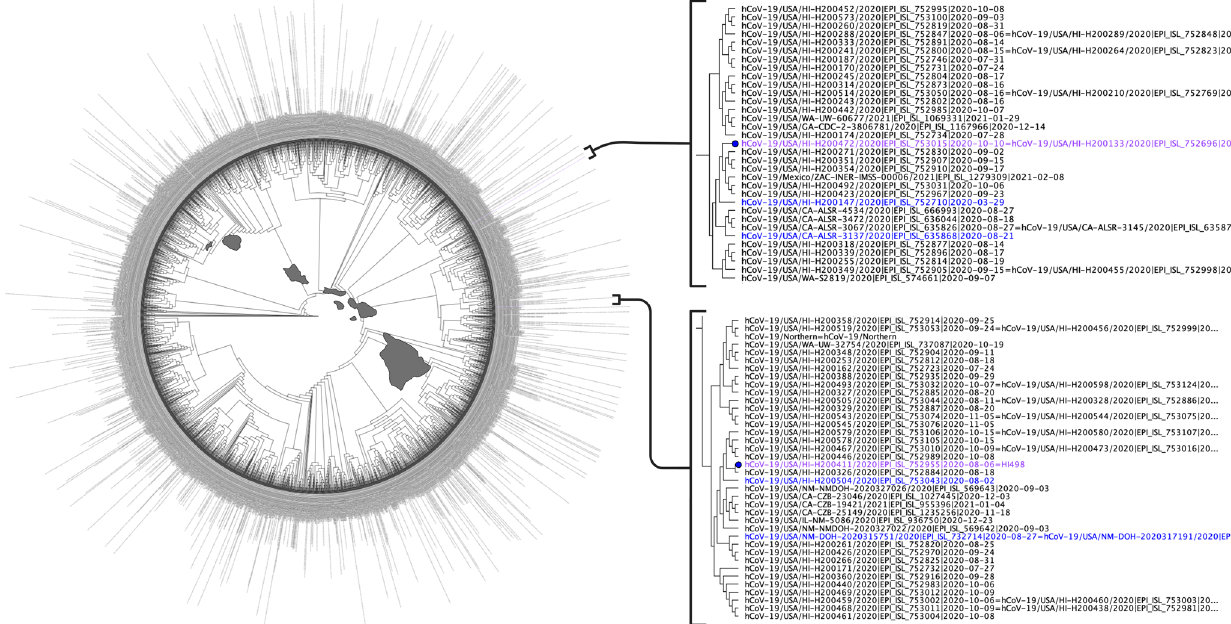
Fig. 6 Phylogenetic Tree of all B.1.243 Lineage Sequences Worldwide. This fi gure displays the phylogenetic tree used to determine the origin of the B.1.243 sequences used in this study. We use 8822 SARS-CoV-2 B.1.243 whole-genome sequences published in the Global Initiative on Sharing Avian In fl uenza Data (GISAID) and GenBank as of April 12, 2021 to de fi ne the origin. From the 8822, 4273 had ambiguous nucleotides between the 5 ’ and 3 ’ untranslated regions as determined using multiple alignment using fast Fourier transform (MAFFT). Further, 1588 were duplicate sequences and eight had duplicate identi fi cations as determined by the sRNA Toolbox. Therefore, the fi nal tree was constructed using FastTree in Geneious Prime 2021.1.1 (http:// www.geneious.com) from 2953 unique and unambiguous SARS-CoV-2 whole-genome sequences. The HI498 (purple text) origin is de fi ned as New Mexico (blue text) and the HI-708 (purple text) origin is de fi ned as California (blue text). Map prepared with R and usmaps package with a GNU